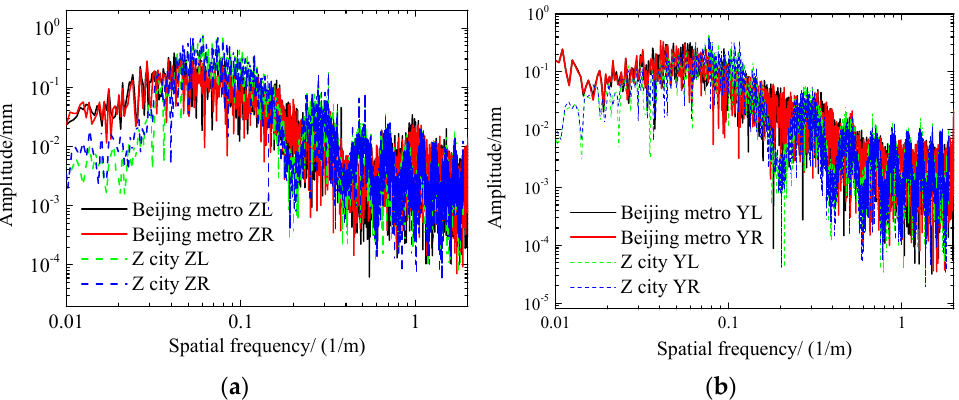
Figure 11. Comparison of the measured irregularity in Z City Metro and Beijing Metro: ( a ) vertical irregularity; ( b ) lateral irregularity.